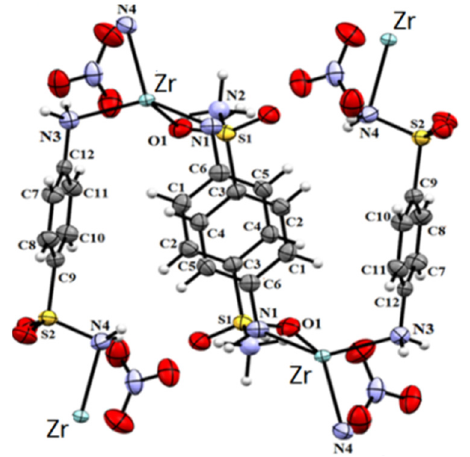
Figure 8: Environment of zirconium in the compound ( 1 ) [ Zr ( C ) ] 2 + · 2 ( NO ) − . 12 H 17 N 4 O 4 S 2 2 3